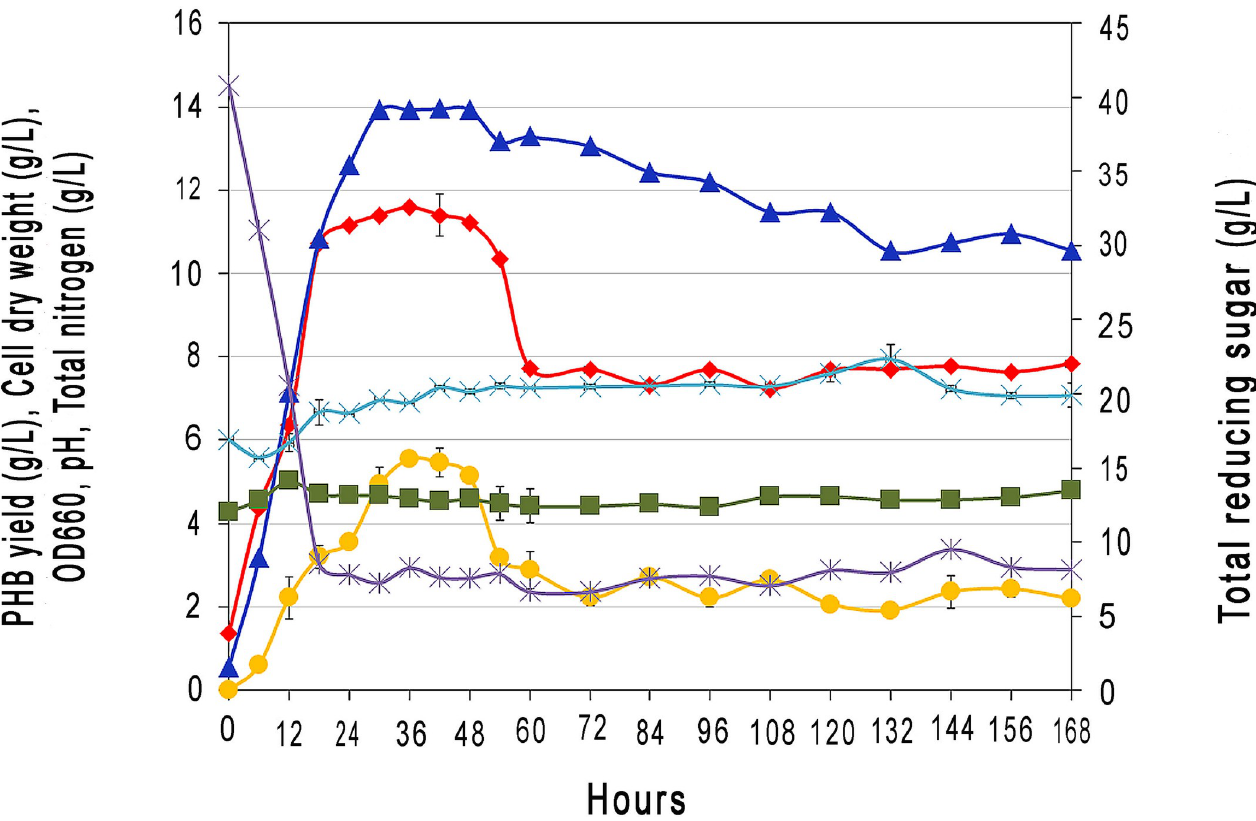
Fig 4. Time course of cell growth and PHAs accumulation of Bacillus drentensis BP17 grown in submerged culture of optimized medium with EPPJ as carbon source and TSB medium: ( ◆ ) Cell dry weight (g/L); ( ▲ ) OD600; ( ■ ) Total nitrogen (g/L); ( ✳ ) Total reducing sugar (g/L); ( × ) pH and ( ● ) PHAs yield